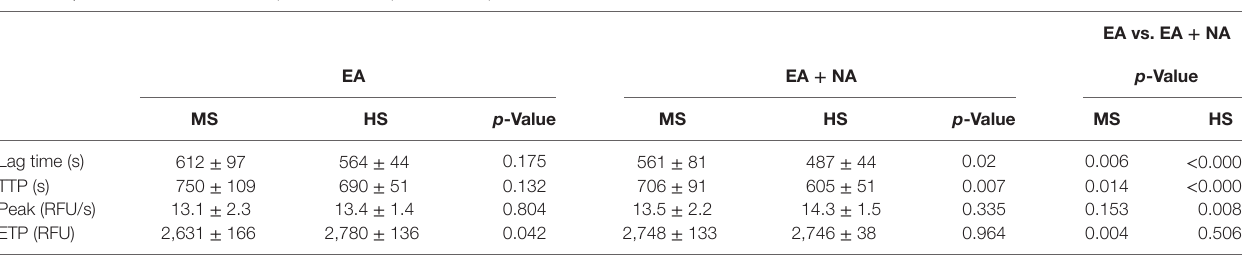
TaBle 5 | Generation of thrombin in plasma of multiple sclerosis patients and HS.